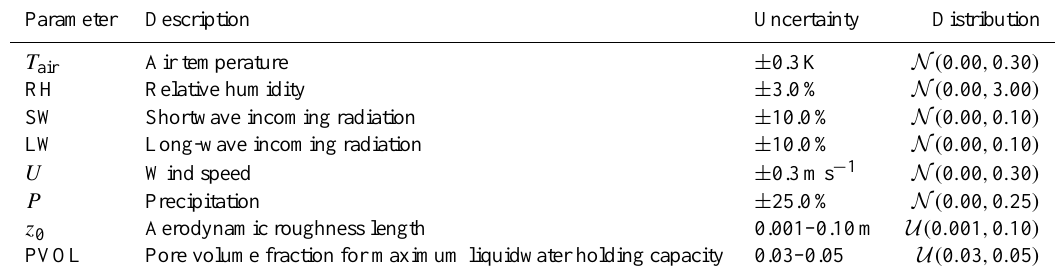
Table 2. Specification of basic model input uncertainties and assigned probability density functions. The Sobol sequence has been generated from the distributions given in the last column, where N (µ,σ) is a normal distribution with mean µ and standard deviation σ , and U (lb,ub) is a uniform distribution in the interval [ lb,ub ]